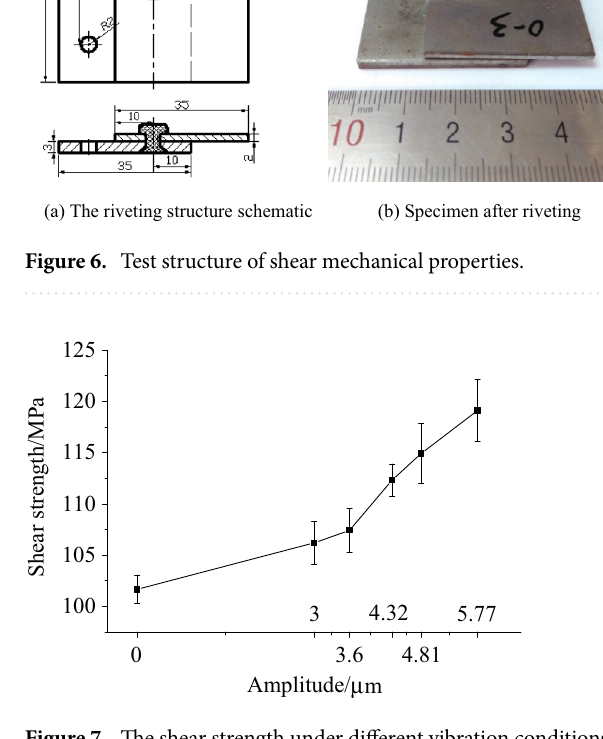
Figure 7. The shear strength under different vibration